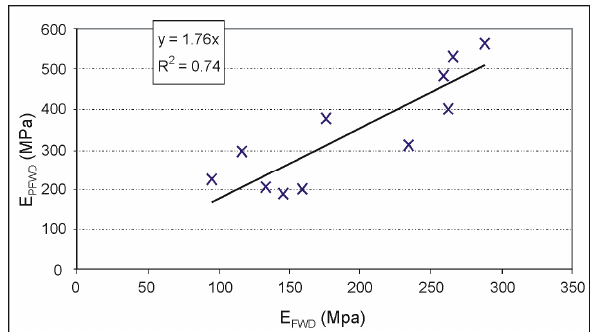
Fig. 9. Relationship between PFWD modulus and FWD